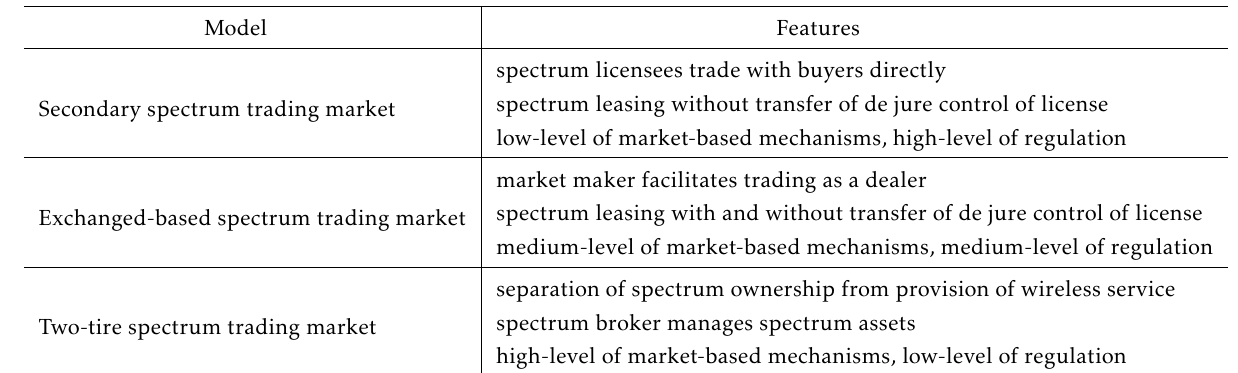
Table. 1. Comparison of different models for spectrum trading